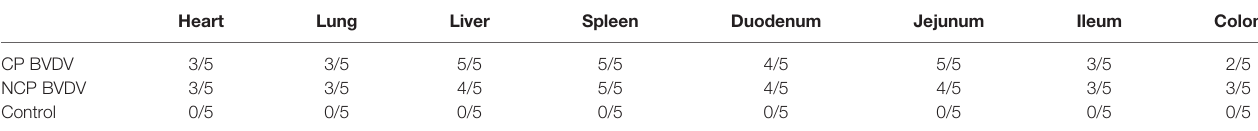
TABLE 1 | Distribution of BVDV-speci fi c antigen at day 7 of post-infection in the fi ve mice infected with each BVDV strain. Heart Lung Liver Spleen Duodenum Jejunum Ileum Colon